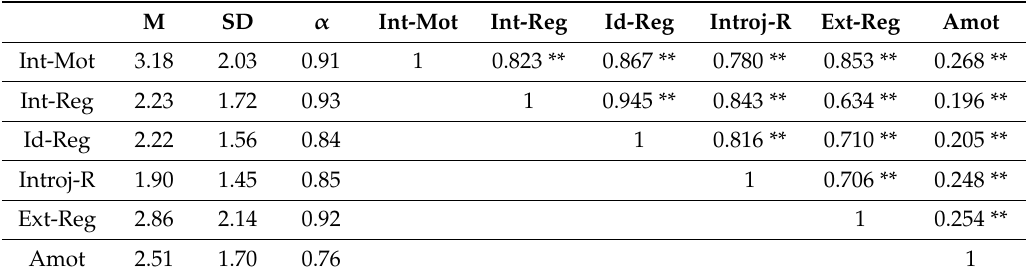
Table 2. Descriptive Statistics, Cronbach’ alphas and Correlations among the six GAMS-it factors (listwise missing deletion, N =